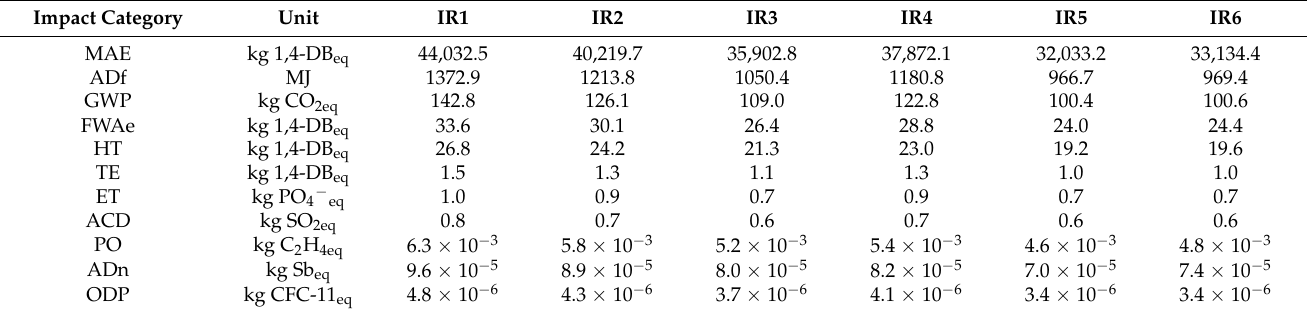
Table 4. Environmental performance of different irrigation scenarios based on their midpoint